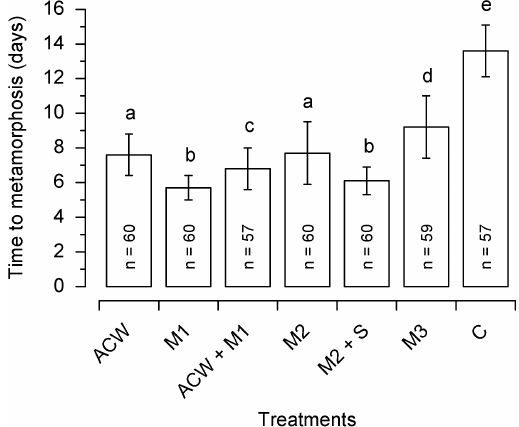
Fig. 2 – Effects of substrata from different mangrove habitats (well- preserved and degraded habitats), adult-conditioned seawater and fil- tered pure seawater on the development time to metamorphosis (aver- age ± standard deviation) of Uca vocator megalopae. See Table I for abbreviations. Numbers inside bars refer to the number of metamor- phosed megalopae with initial n = 60 specimens randomly distributed among three replicate vials per treatment. Different letters above bars indicate significant differences ( P < 0 . 05) after pair-wise comparisons using Dunn’s or Mann-Whitney’s